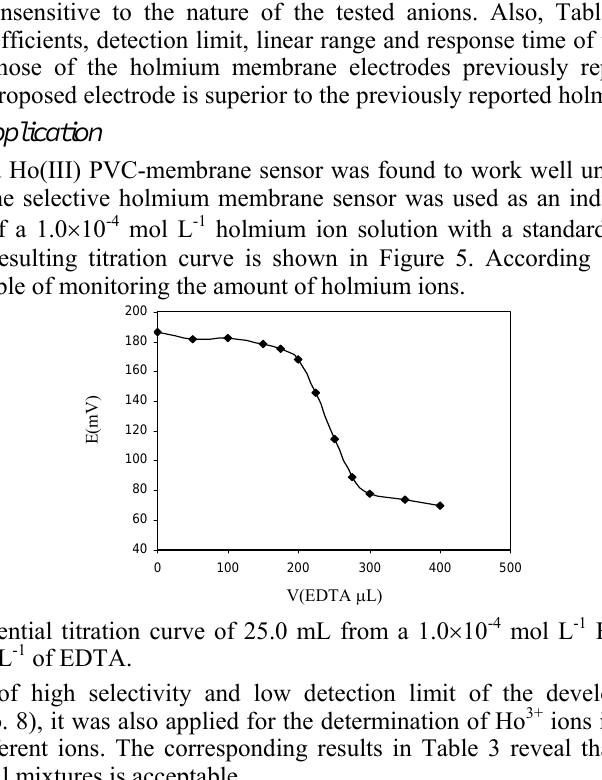
Table 3. Determination of Ho 3+ ions in mixtures of different ions S.